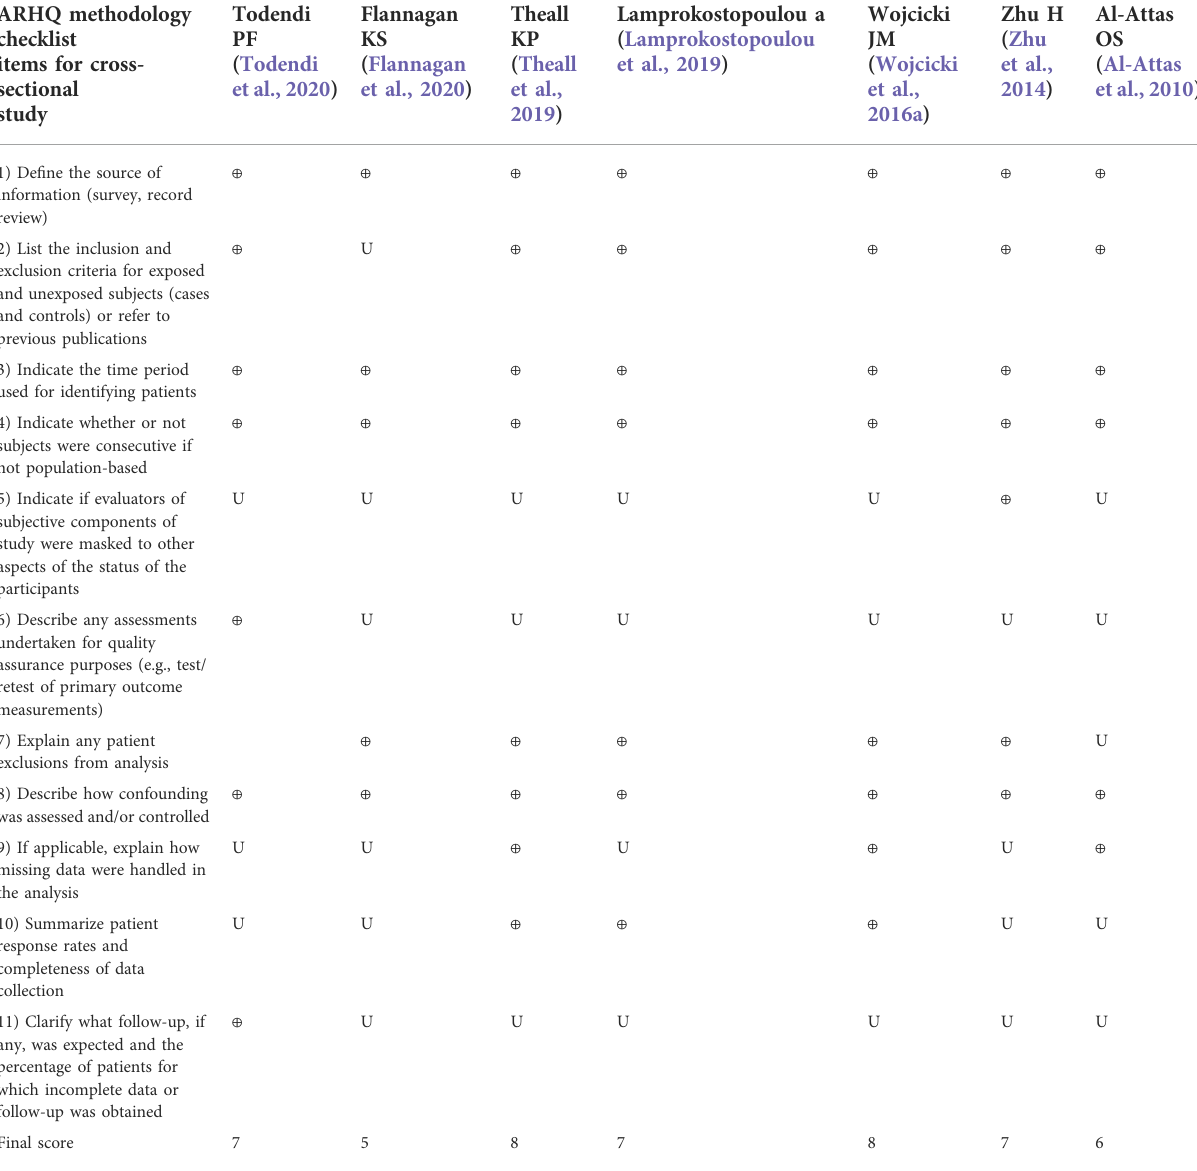
TABLE 2 Risk of bias assessment using the Agency for Healthcare Research and Quality (AHRQ)